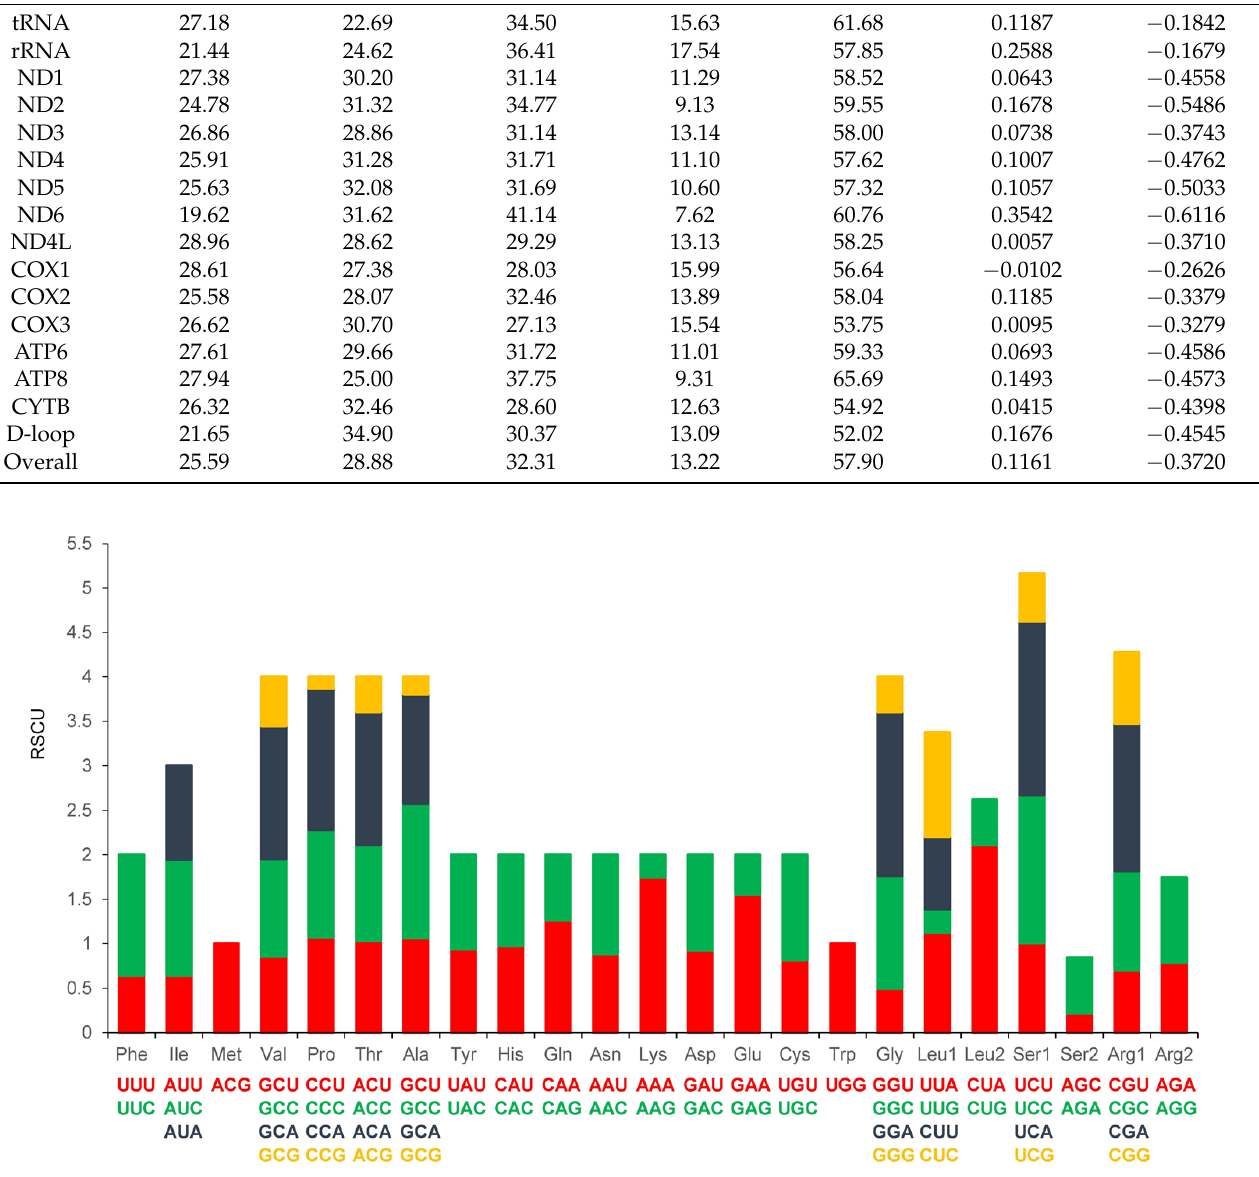
Figure 3. Relative synonymous codon usage (RSCU) in the Huaibei grey donkey mitochondrial genome.